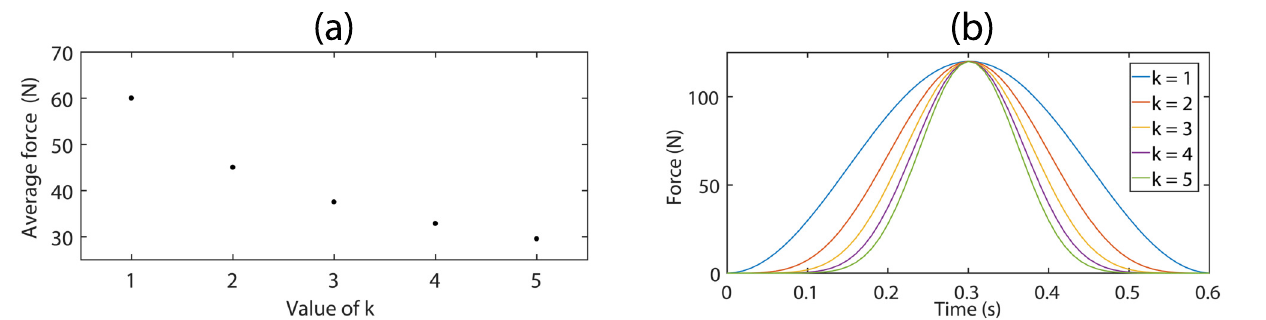
( 2 k ) , of the stroke function (Equation (33)) for different values of parameter k (see text), Figure 6. ( a ) Average force f 0 k 2 2 k ( b ) stroke function (Equation (33)), with f 0 = 120 N, for the same values of parameter k (see